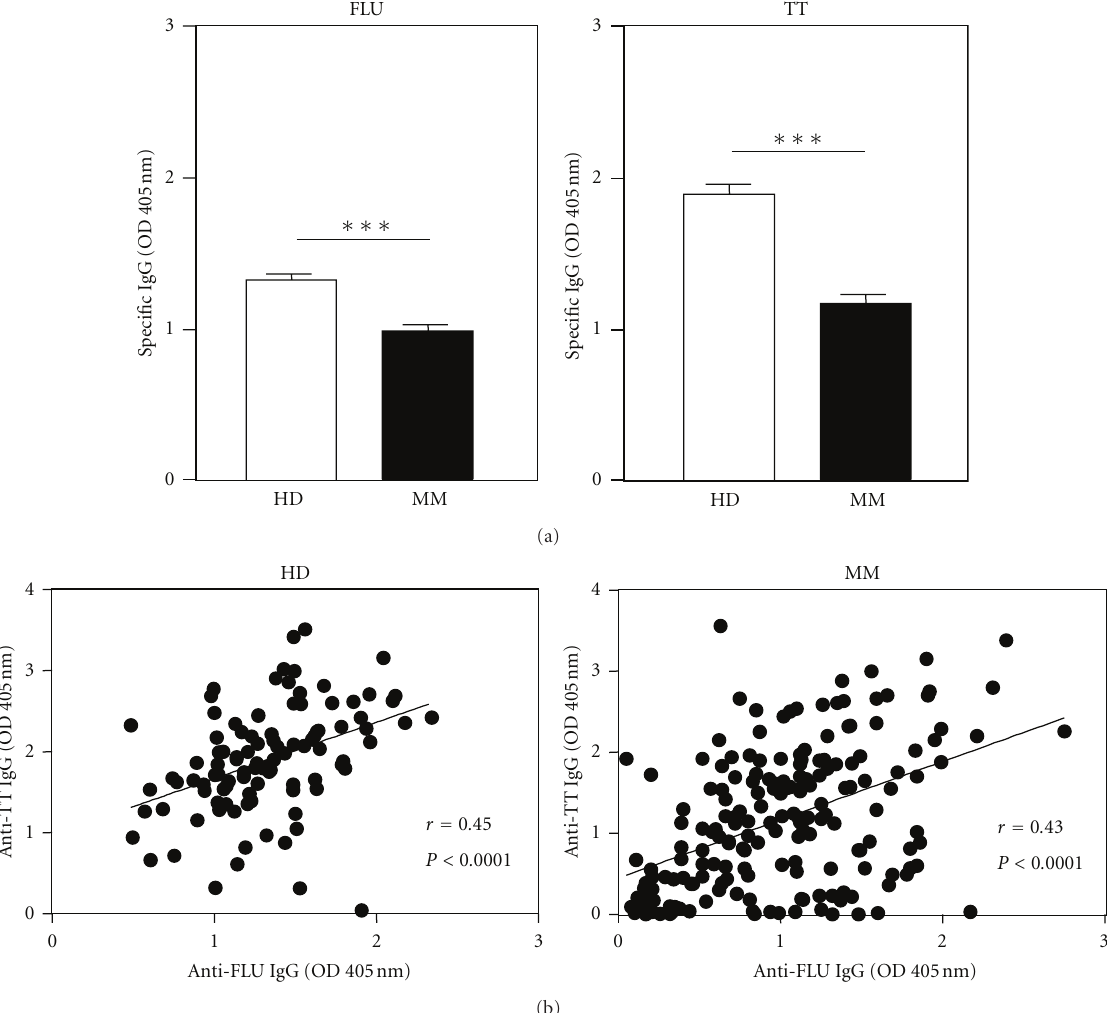
Figure 1: Comparison of levels of FLU- and TT-specific antibodies in MM patients compared to healthy donors. (a) Mean values for FLU- and TT-specific specific antibodies for HD ( n = 100) and MM patients ( N = 190). OD 405 nm of the background control GST was subtracted for each sample. Asterisks indicate significant di ff erences ( ∗∗∗ P < 0 . 001) between groups. (b) Correlational analysis of FLU- and TT-specific antibodies in HD ( N = 100) and MM patients ( N =